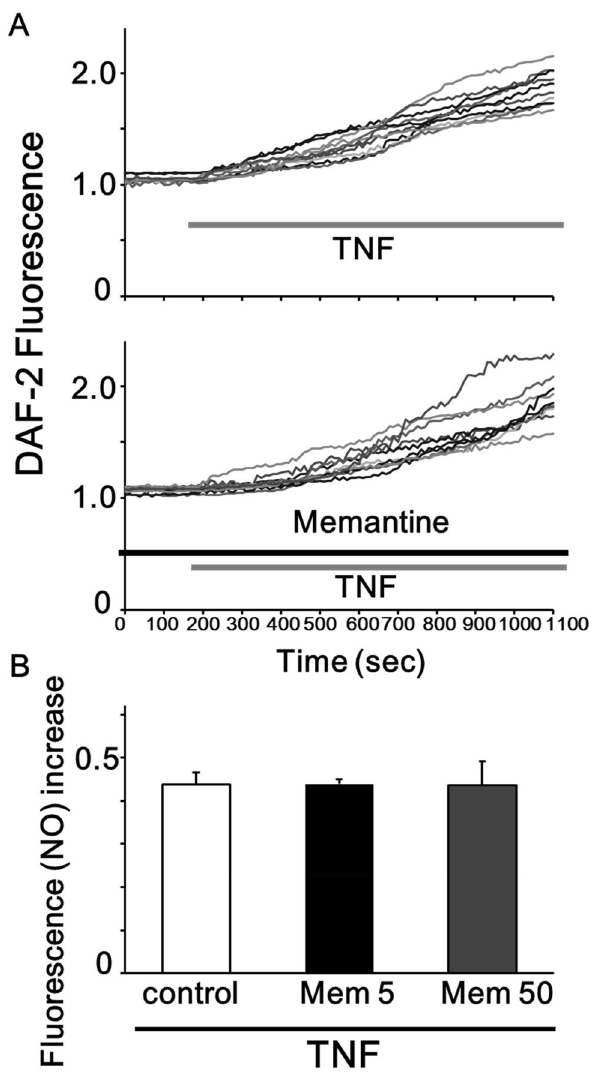
Figure 1. Pretreatment with memantine did not affect the production of NO induced by TNF in rat HAPI microglial cells. ( A ) Ten representative traces showing the treatment of 0.1 ng/mL TNF induced the increase in the DAF-2 fluorescence (upper) and 12 h pretreatment with 5 μM memantine did not affect the TNF- induced increase in the DAF-2 fluorescence in rat HAPI microglial cells (lower). ( B ) Bar graphs showing that pretreatment with memantine did not the production of NO induced by TNF treatment. Pretreatment of memantine did not affect the amount of TNF-induced increase in the DAF-2 fluorescence at 15 min after a TNF-treatment in rat HAPI microglial cells (0.437 ± 0.024, n = 135 cells in control; 0.439 ± 0.023, n = 145 cells in 5 µM memantine; p =